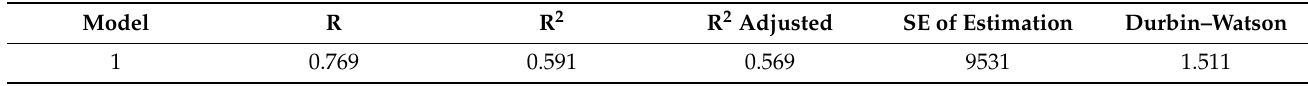
Table 6. Summary of the regression model a .